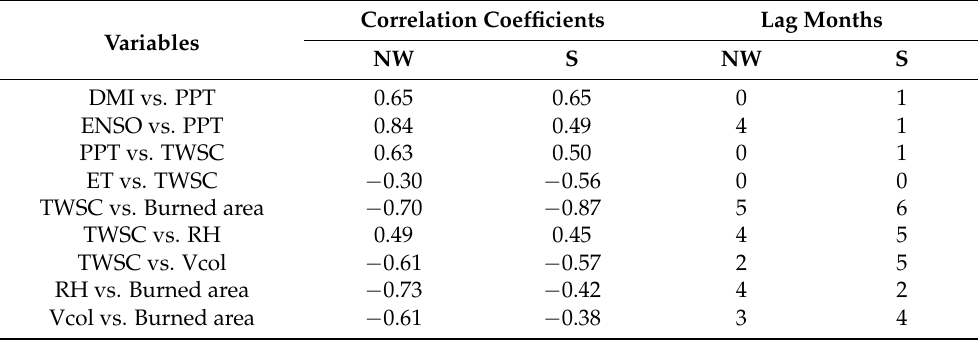
Table 6. The maximum correlation coefficients and lag months between different variables shown in Figure